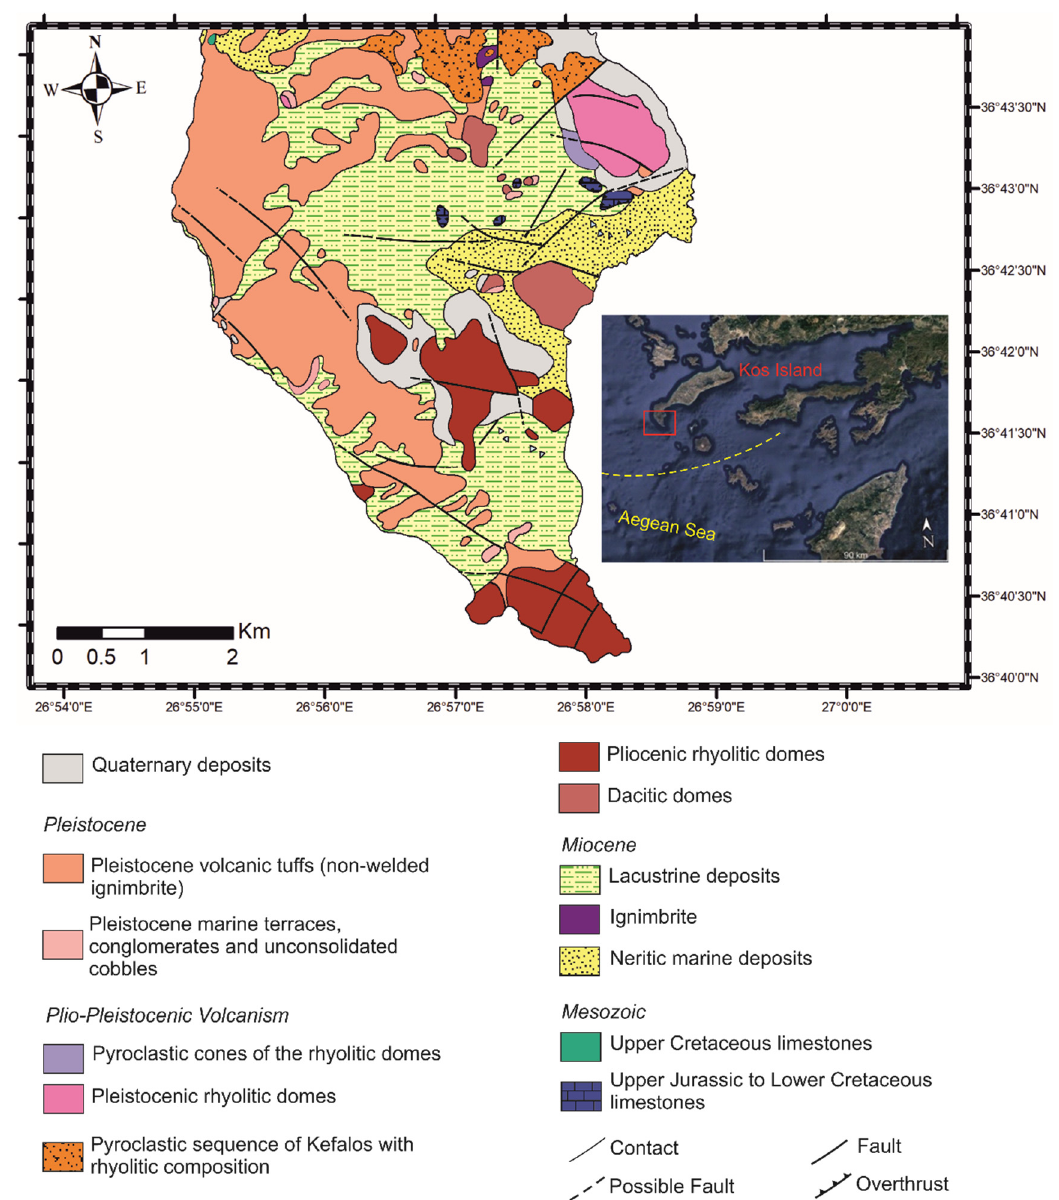
Figure 1. Digitised geologic map of Kefalos Peninsula (modified after [31]) and satellite view of Kos island in the south-east Aegean Sea, provided by Google Earth Pro.